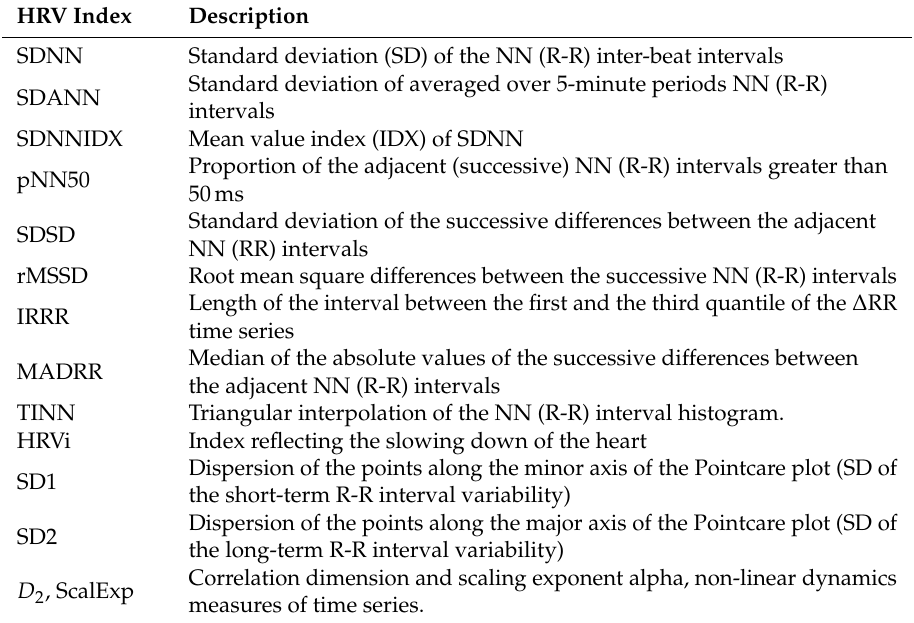
Table 1. Description and explanation of abbreviations of the heart rate variability (HRV) parameters applied in this study. Hereafter, NN refers to the time elapsed between consecutive ’normal-to-normal’ beats of the heart, equivalent to R-R, that is, peak-to-peak period between the R-waves on the